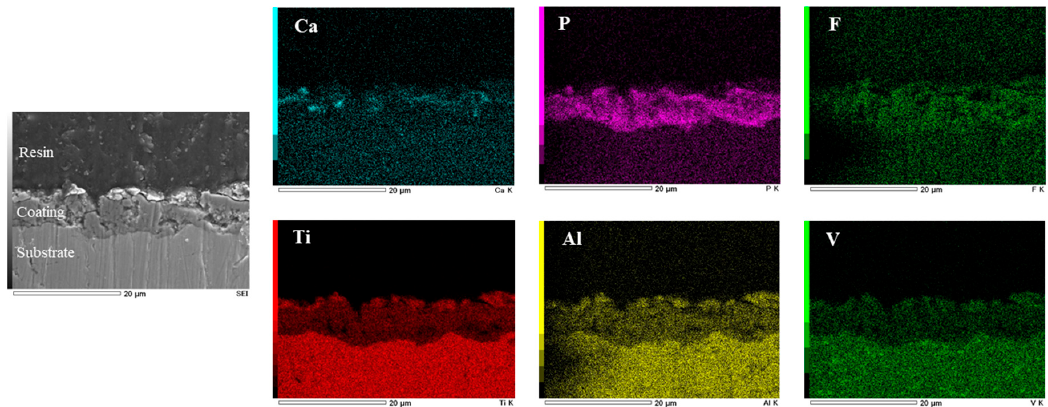
Figure 8. Cross-section EDS maps of the coating with different chemical elements, namely Ca, P, F, Ti, Al and V.